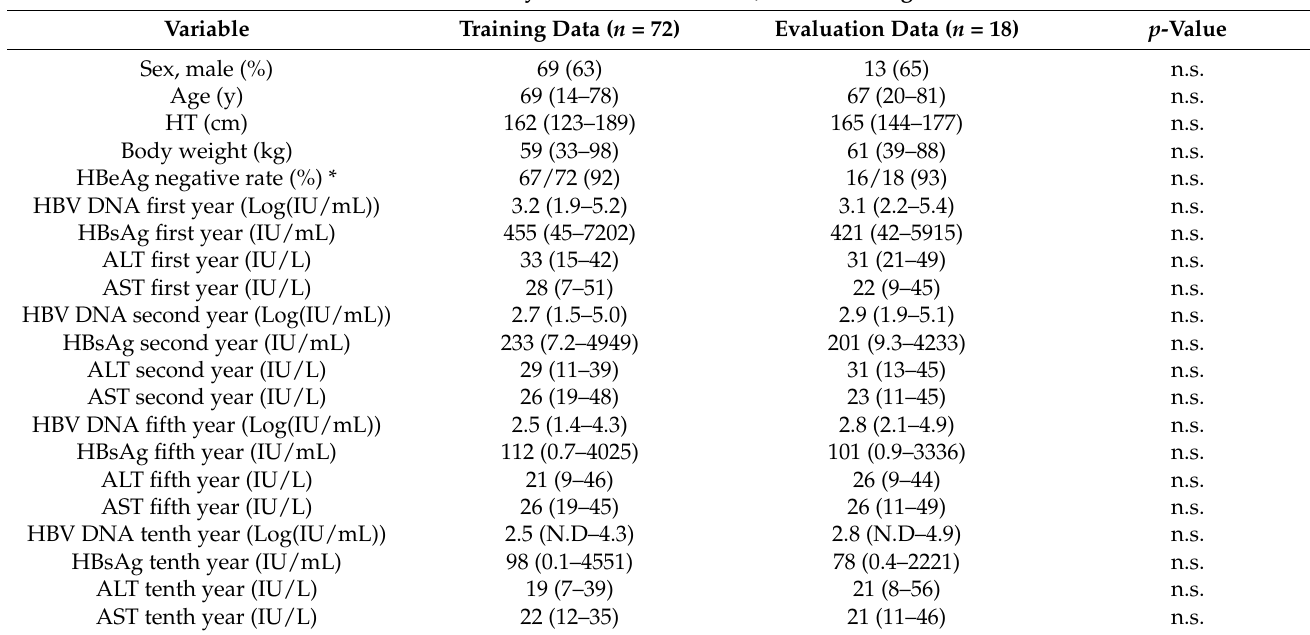
Table 1. Baseline characteristics of participants enrolled in the study of training data and evalua-